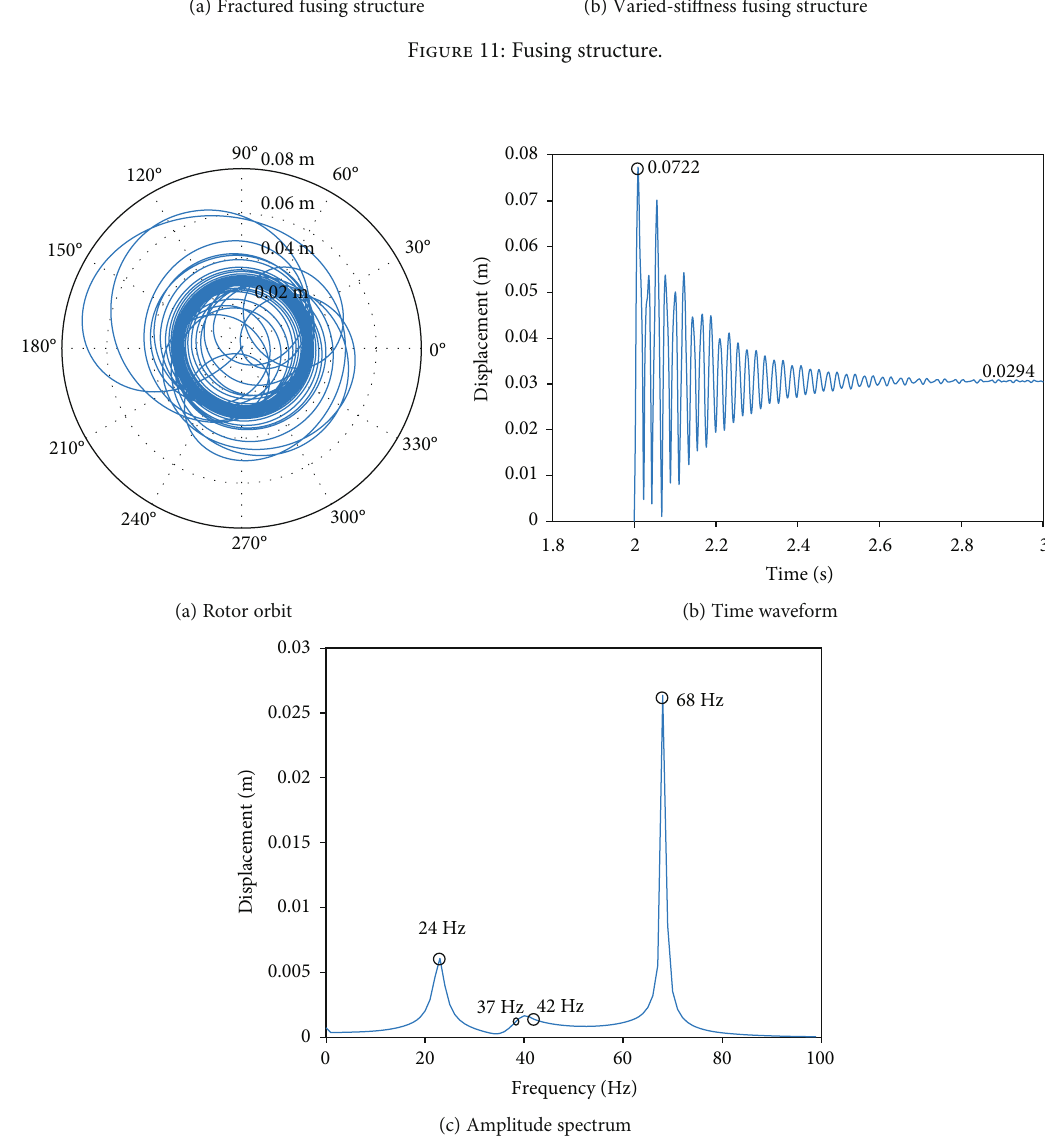
Figure 12: Response of a rotor system with varied-sti ff ness fusing